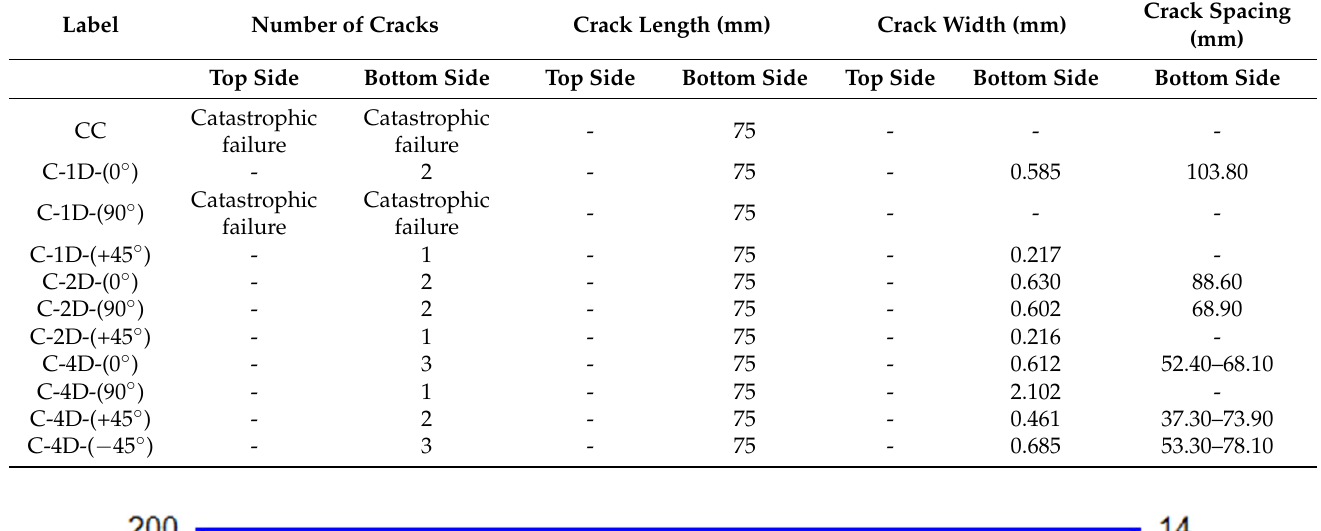
Table 6. Off-axis flexural failure results of multiaxis 3D carbon fiber concrete.